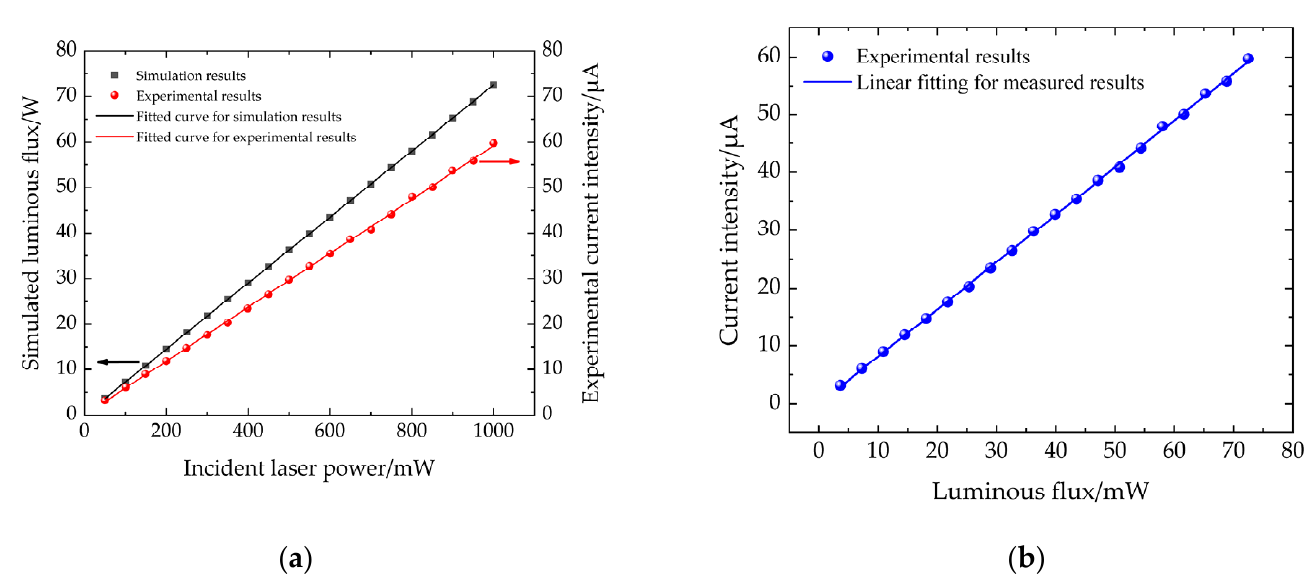
Figure 11. Detector calibration results: ( a ) variations of simulated luminous flux and experimental current intensity with incident laser power; ( b ) calibration relationship between the experimental current intensity and the simulated luminous flux.